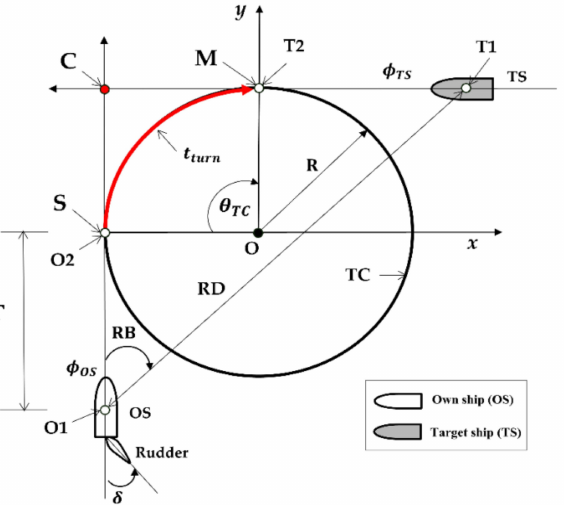
Figure 1. Description of relationship between own ship and target ship while introducing the turning circle of the own